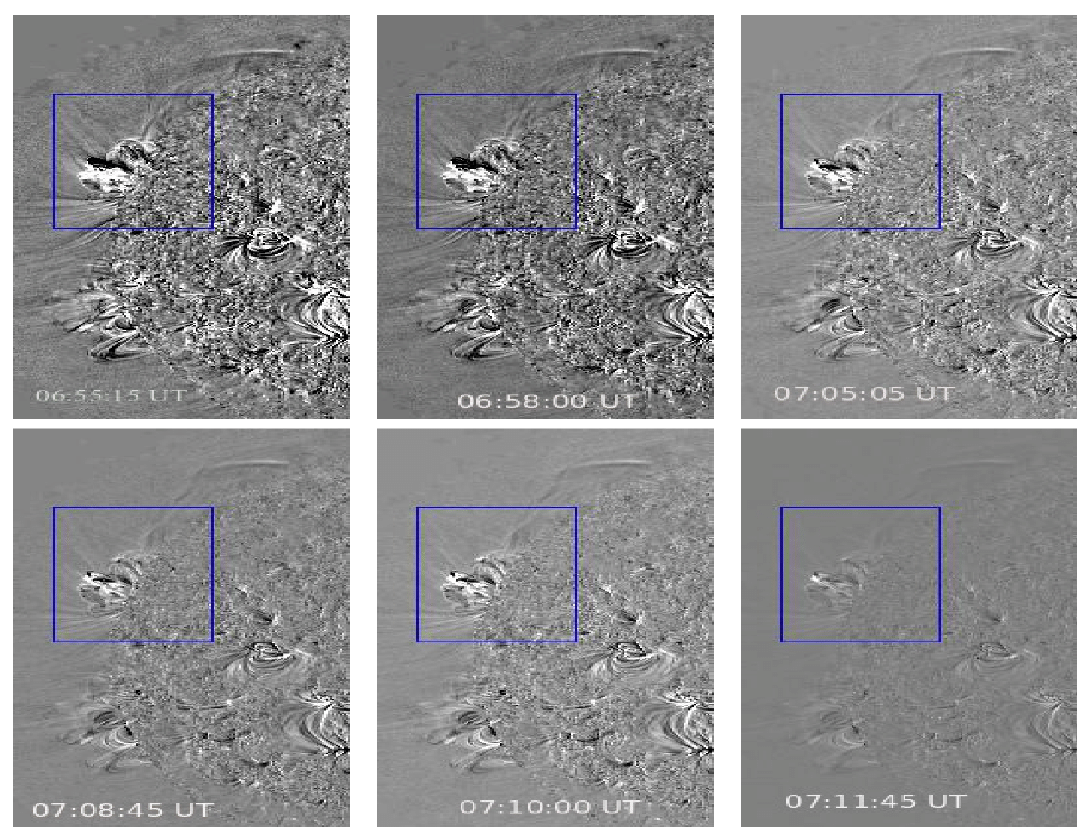
Figure 4. AIA/SDO portion images of the Sun, using the 171Å bandpass on 3 November 2014. These are running difference images corresponding to 6 type III radio bursts among 11 bursts observed on 3 November 2014 from 06:55:15 to 10:04:05UT, respectively. This figure shows the region of the open magnetic field lines enclosed by blue rectangles which are the path of electron beams emitting type III radio